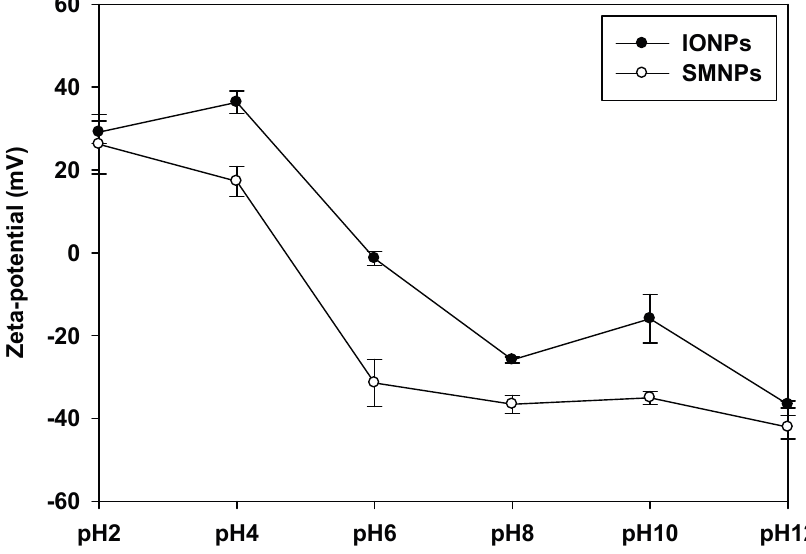
Figure 2. Zeta potential of surface-modified nanoparticles (SMNPs) and iron